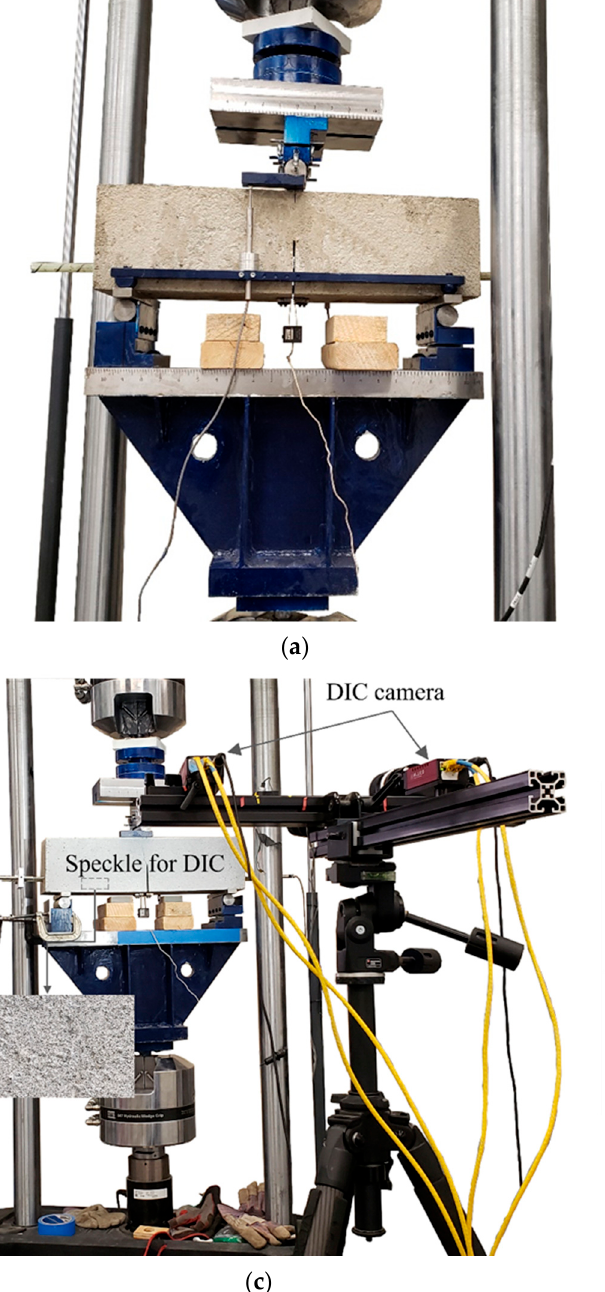
Figure 3. Test set-ups and molds: ( a ) Photo of the test set-up; ( b ) Molds for the GFRP bar reinforced beam and cast notch beam; ( c ) DIC set-up for a test; ( d ) Configuration of the test